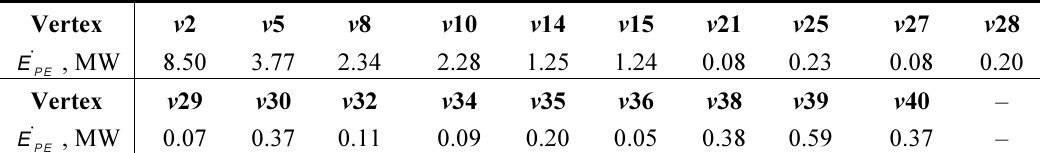
Table 1. Heat flow, supplied to vertices.